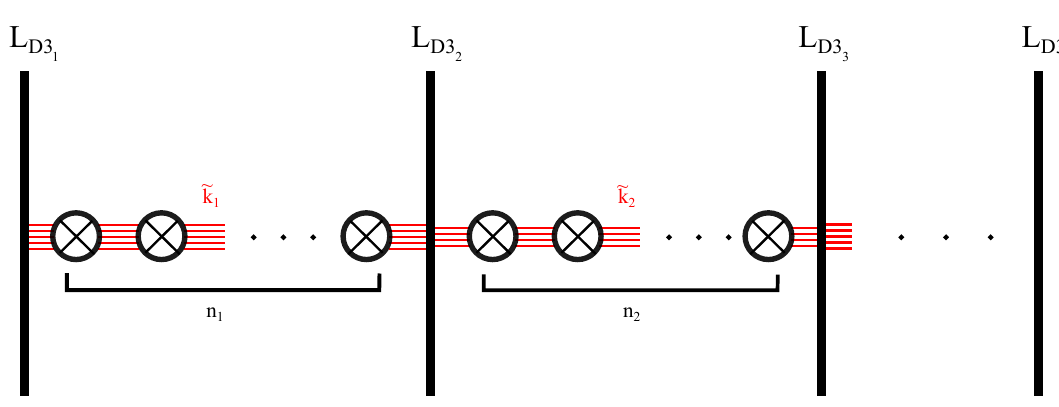
Figure 12 . D1-D3-NS5 con(cid:12)guration for monopole bubbling in a SU( N ) theory. The number of NS5-branes in the i -th chamber is n i . The number of D1-branes in the i -th chamber (begin- ning/ending on D3-branes) is the same and denoted by e k i , where e k i s are de(cid:12)ned in